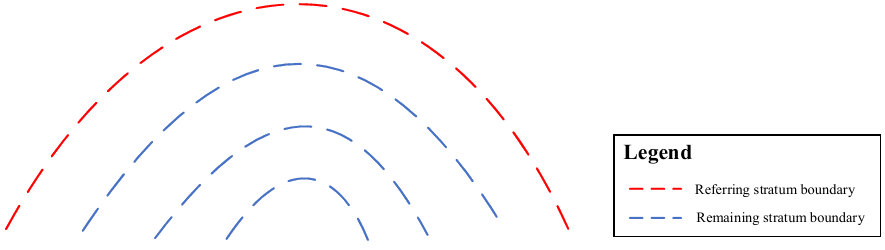
Figure 3. Determination of cross ‐ section locations: ( a ) extraction of location parameters based on a geological map and ( b ) location of sections based on location parameters. S1 ‐ S3 are different stratum codes.